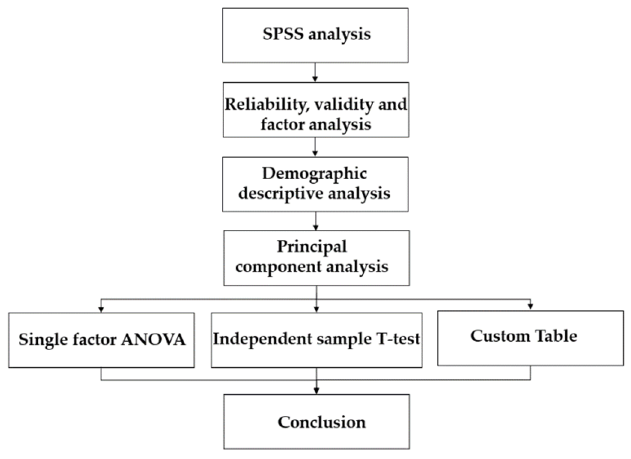
Figure 6. SPSS analysis frame diagram